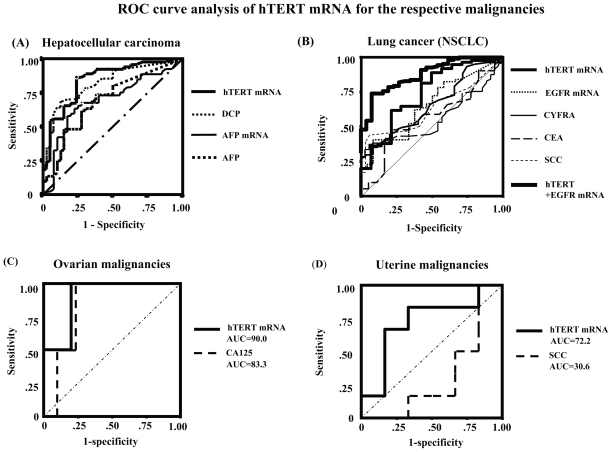
Receiver operator characteristic (ROC) curve analysis of the hTERT mRNA and/or EGFR mRNA expressions in comparison with conventional tumor markers. The curves shown were obtained by processing quantified raw data by SPSS II software and the sensitivity/ specificity values were predicted from the area under the curves and the calculated data. (A) For hepatocellular carcinoma, (B) for lung cancer (NSCLC), (C) for ovarian malignancies, and (D) for uterine malignancies.